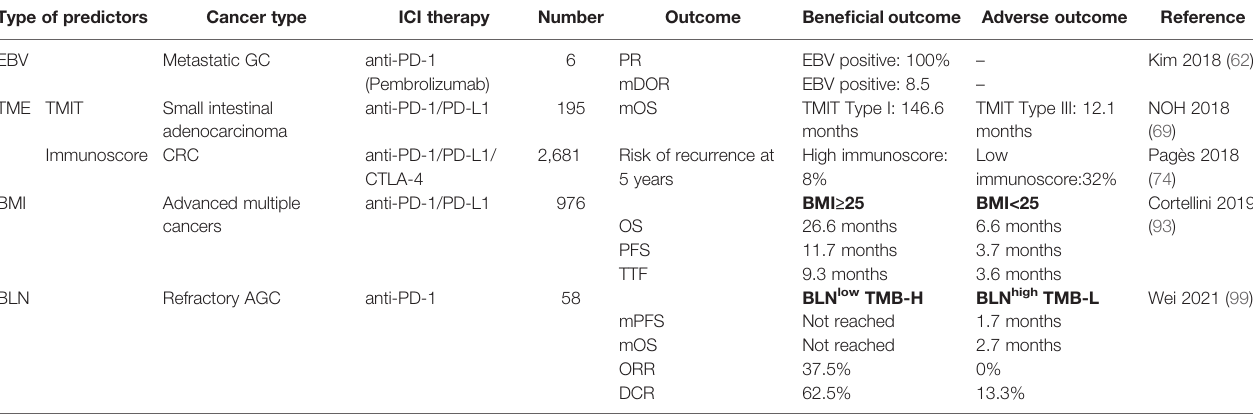
TABLE 4 | Predictive ability of EBV, TME, BMI, and BLN for response to ICI therapy for digestive system cancers. Type of